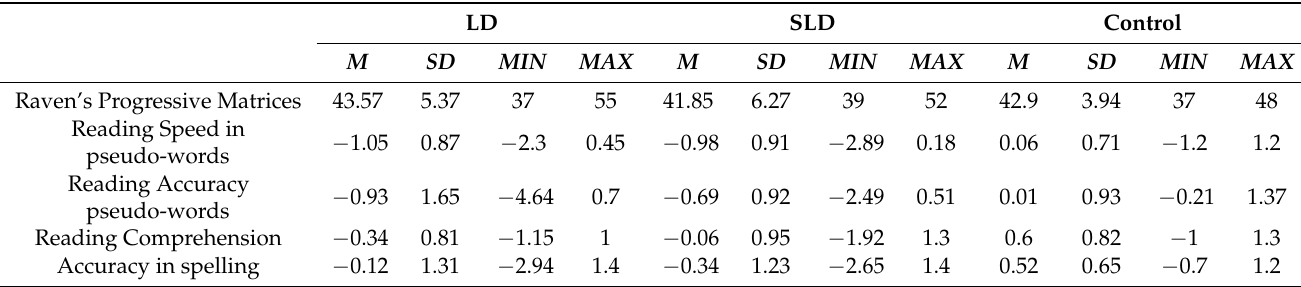
Table 1. Means and standard deviations for scores at the Raven’s Progressive Matrices and z-scores on the literacy skill tests, for the three